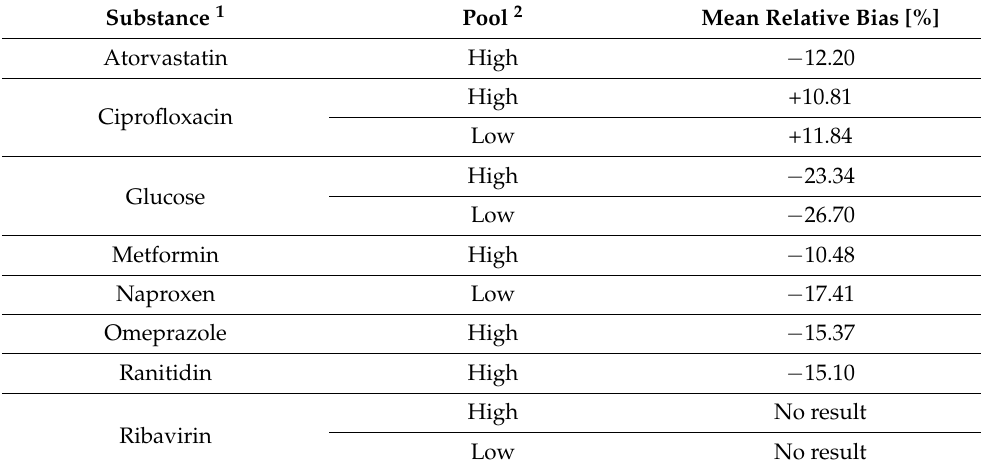
Table 4. Potentially interfering substances with mean relative bias > ± 10% in at least one serum pool in the interference